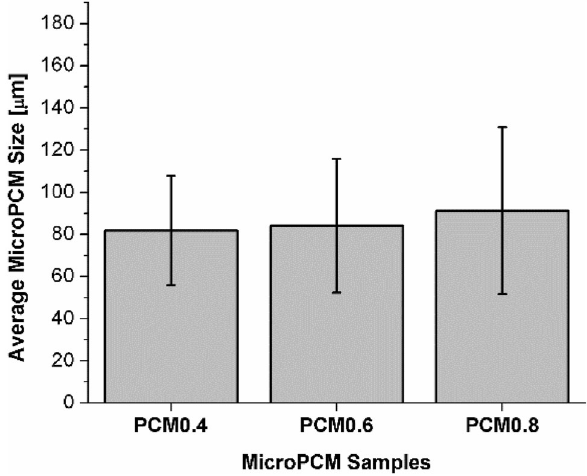
Fig. 3 Effect of PA content on microPCM’s